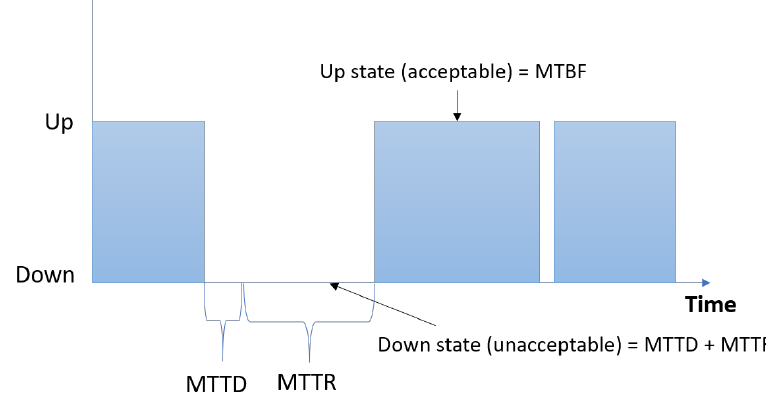
Figure 5. Representation of the availability Figure 5 . Representation of the availability concept.